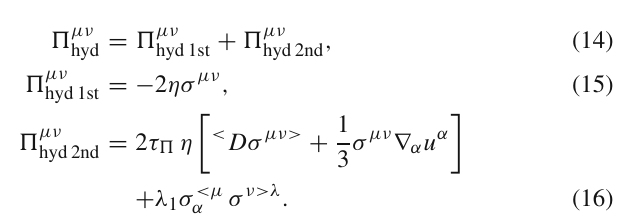
Fig. 2. In this sense, the evolution of the energy density moves with increasing ˆ γ further away from the light cone, although particles located in the tails of the system and propagating outwards will always escape along the light